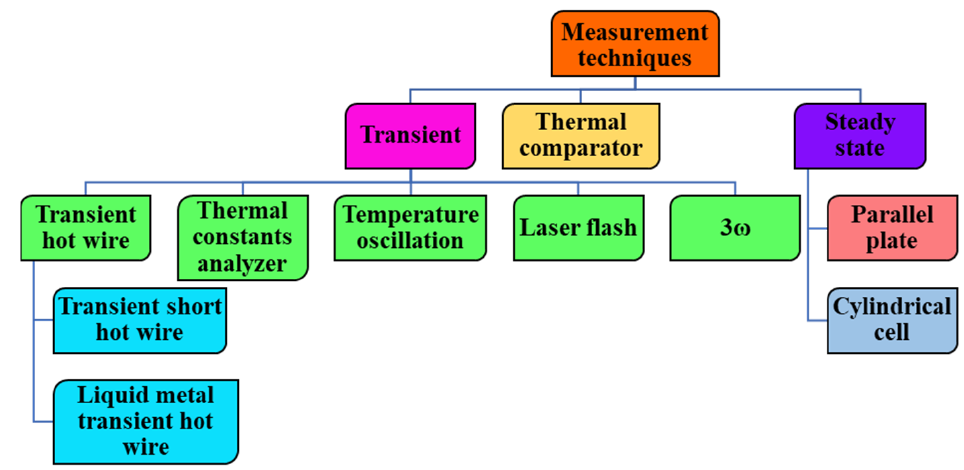
Figure 2. Division and sub-division of thermal conductivity measurement techniques.